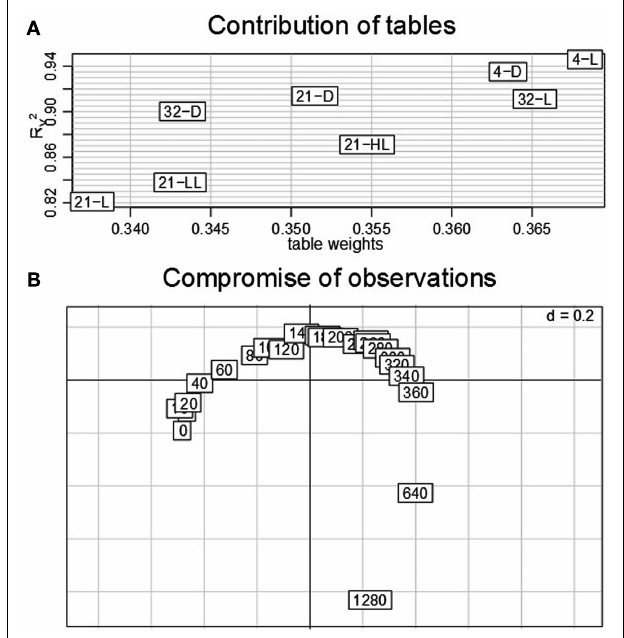
FIGURE 6 | Dual-STATIS analysis of the data set. Here, the tables are transposed in order to characterize each condition by the time points (in this setting corresponding to observations). (A) Table weights and R V coefficient discriminate the influence of tables. (B) The contribution of the individual time points (0–1280min) to the principal components allows describing to progression of transcriptional adjustments in Arabidopsis over the complete